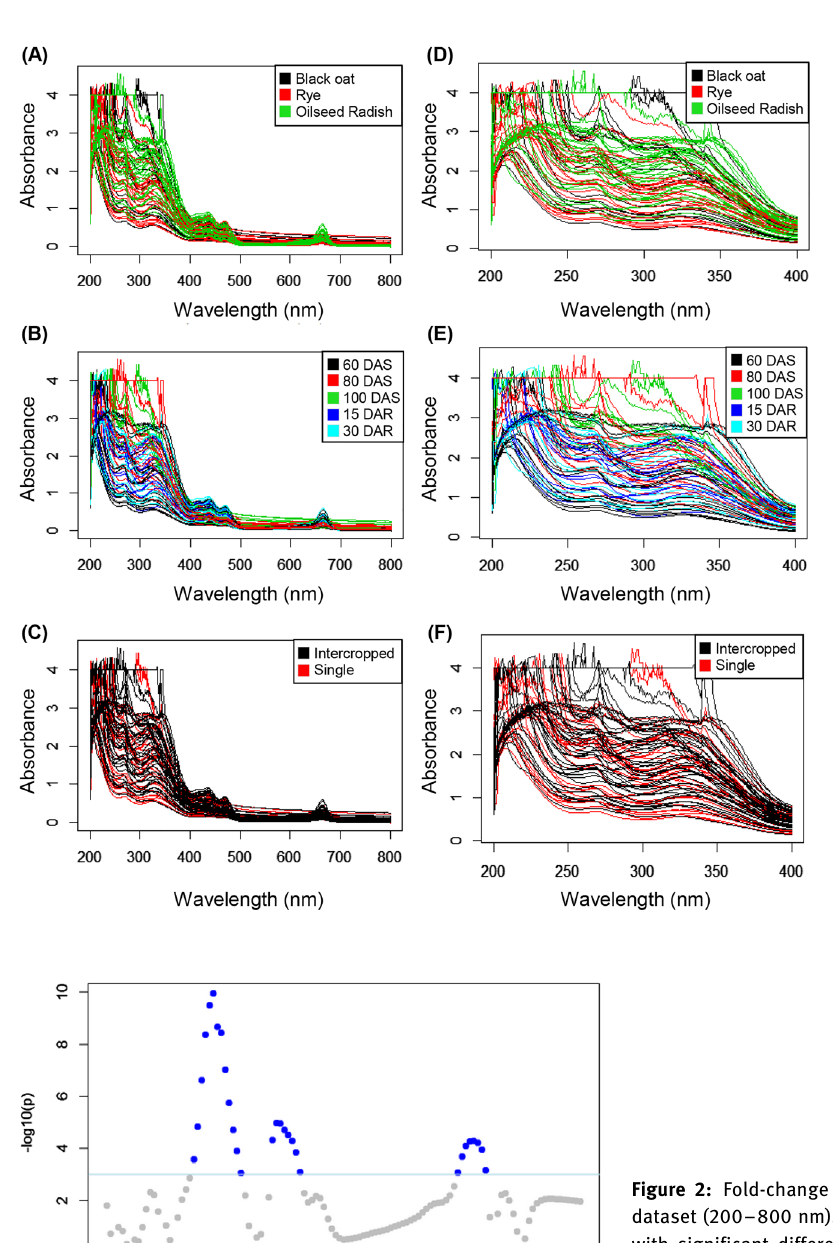
Figure 2: Fold-change analysis of the UV–vis spectra dataset (200–800 nm). Blue dots indicate wavelengths with significant differences ( p < 0.05). Samples were statistically different in the region between 300 and 450 nm(phenoliccompoundsandcarotenoids)and650–700 nm